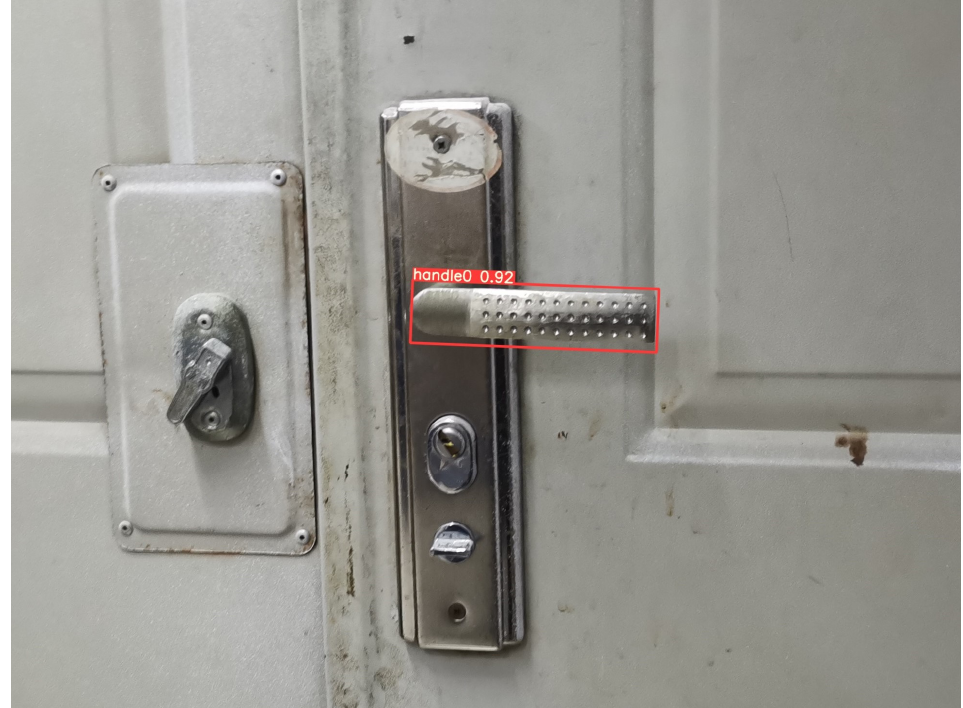
Figure 14. The effect of two types of door handle